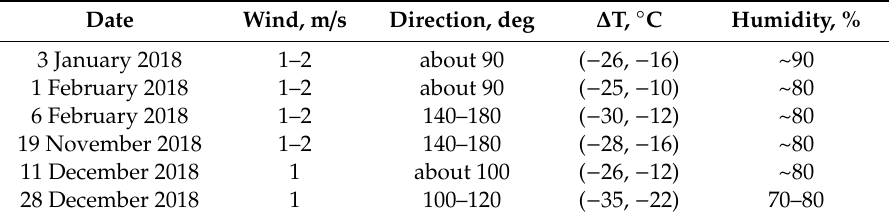
Table 4. The investigated time periods and their meteorological parameters for Tomsk.